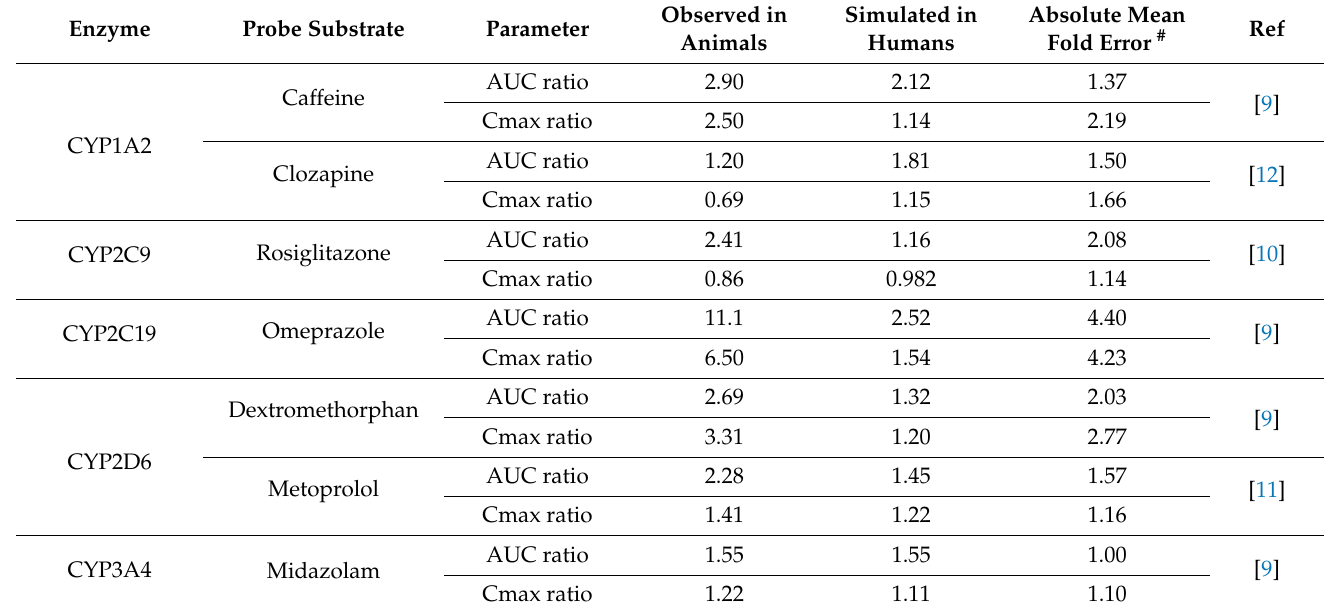
Table 4. Simulated and observed parameter ratios defining the difference in exposure to probe substrates between MAFLD and healthy